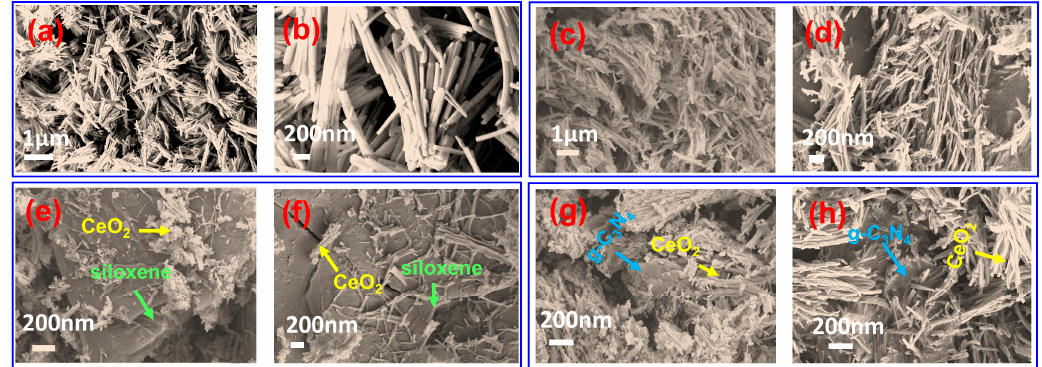
Figure 2. Scanning electron microscope ( SEM) images of ( a , b ) Ce-MOF, pyrolyzed at 350 °C; ( c ) Bare CeO 2; ( e ) CeO 2 /siloxene; ( g ) CeO 2 /graphitic carbon nitride (g-C 3 N 4 ), pyrolyzed at 450 °C; ( d ) Bare CeO 2; ( f ) CeO 2 /siloxene; and ( h ) CeO 2 /g-C 3 N 4 .